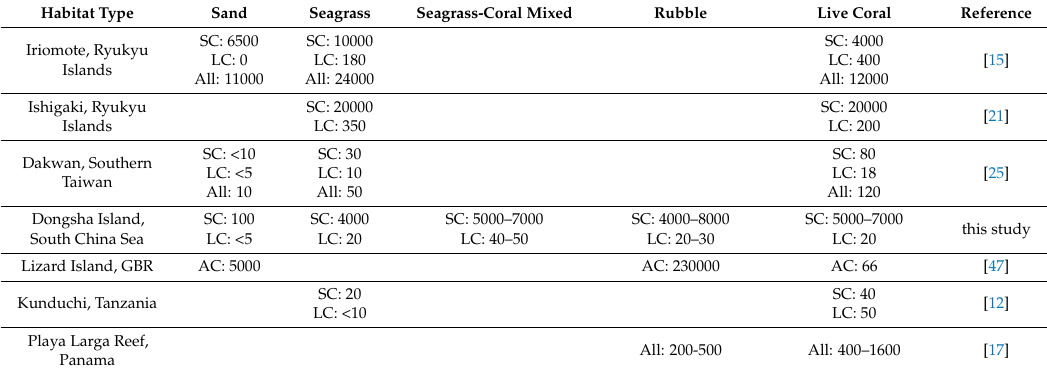
Table 6. Comparisons of benthic invertebrate density (per m 2 ) among various habitat types, as determined by previous studies. Abbreviations: SC: Small crustaceans (amphipods, ostracods, copepods, and tanaids), LC: large crustaceans (decapods), AC: Sum of all crustaceans and All: Sum of all benthic